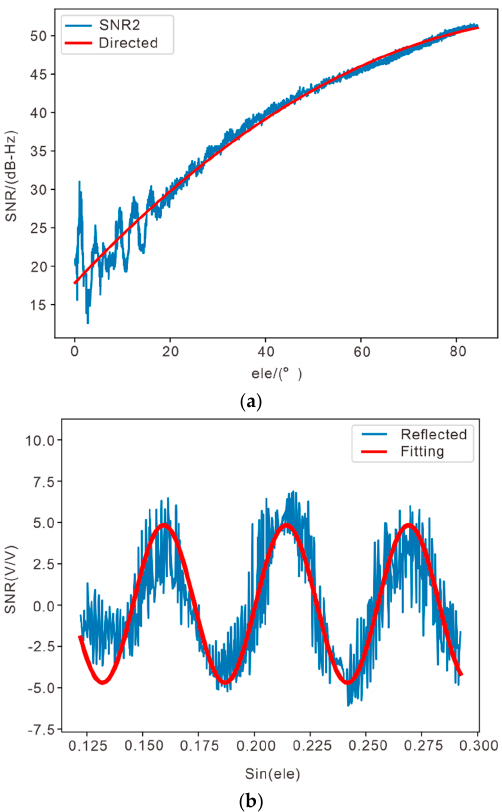
Figure 4. Reflected signal preprocessing. ( a ) L2 SNR data for one GPS satellite are shown in blue. The direct signal is represented by the smooth curve in red; ( b ) SNR data with the direct signal removed and converted to a linear scale.